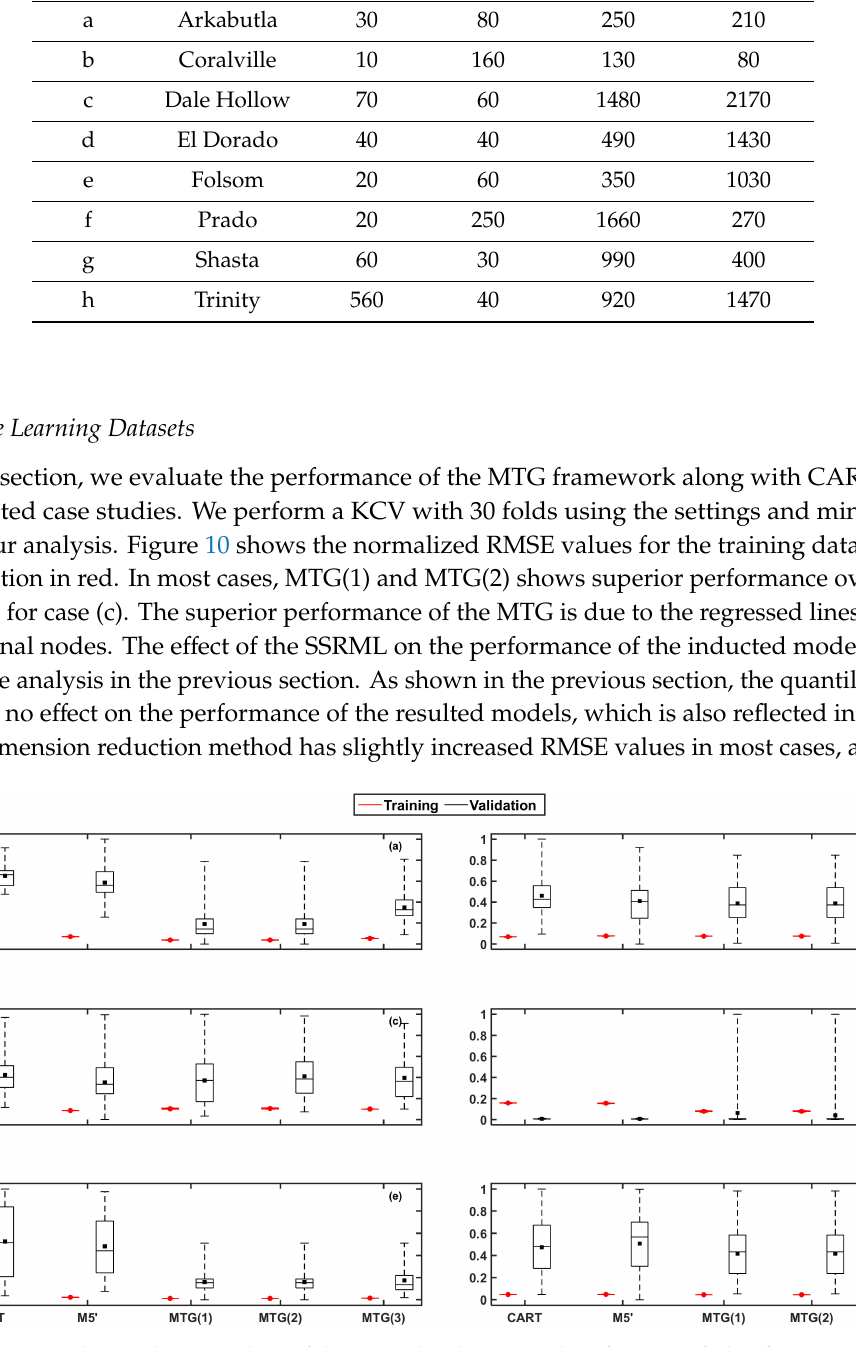
Figure 10. Boxplots and mean values of the normalized RMSE values for; ( a ) airfoil self-noise, ( b ) Auto MPG, ( c ) combined cycle power plant, ( d ) concrete compressive strength, ( e ) energy e ffi ciency (heating load) and ( f ) energy e ffi ciency (cooling load) for training and validation data using the CART and M5 (cid:48) algorithm and MTG